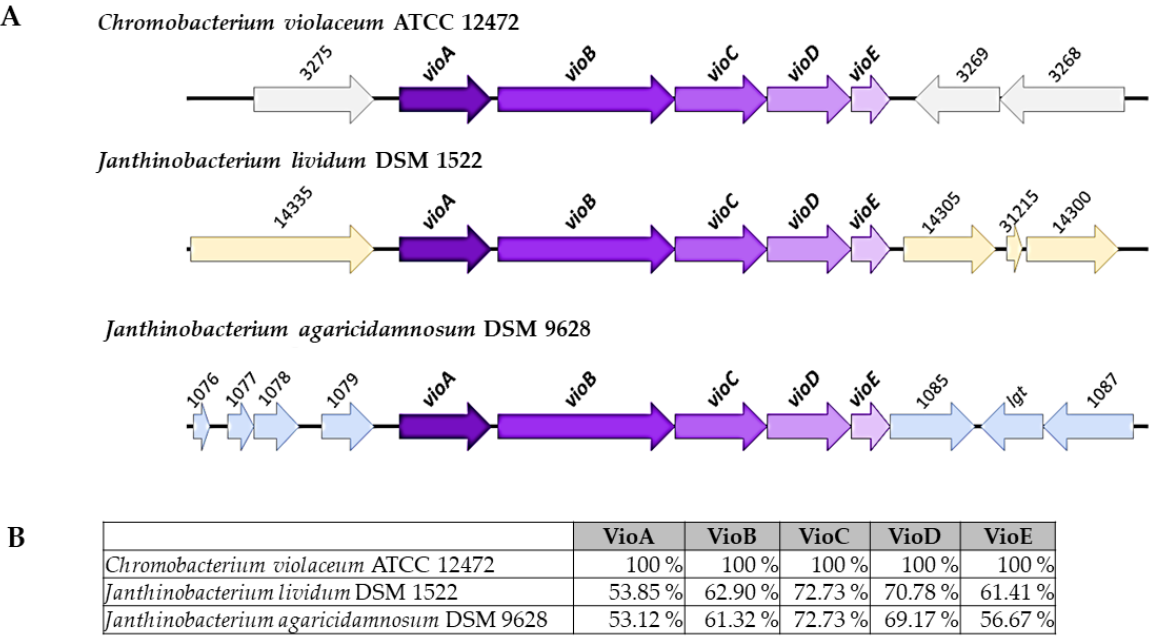
Figure 1. Violacein-producing protein cluster in J. agaricidamnosum DSM 9628 and J. lividum DSM 1552. ( A ). Comparison of vioABCDE protein cluster in C. violaceum ATCC 12472, J. agaricidamnosum DSM 9628, and J. lividum DSM 1552. ( B ). Amino acid sequence similarity of VioA, B, E, D, and C protein between C. violaceum ATCC 12,472 with J. agaricidamnosum DSM 9628 and J. lividum DSM 1552.